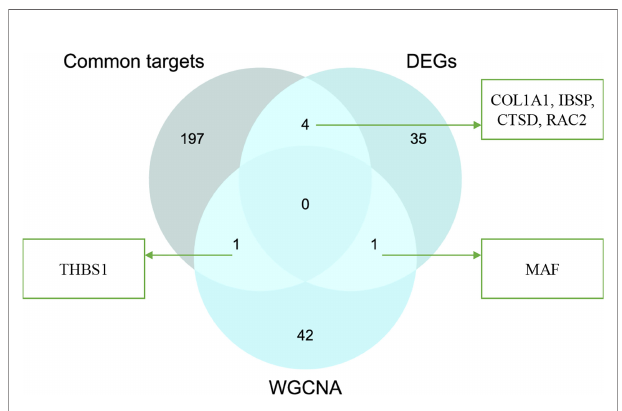
FIGURE 8 | Venn diagram of interaction between common targets and genes from WGCNA and